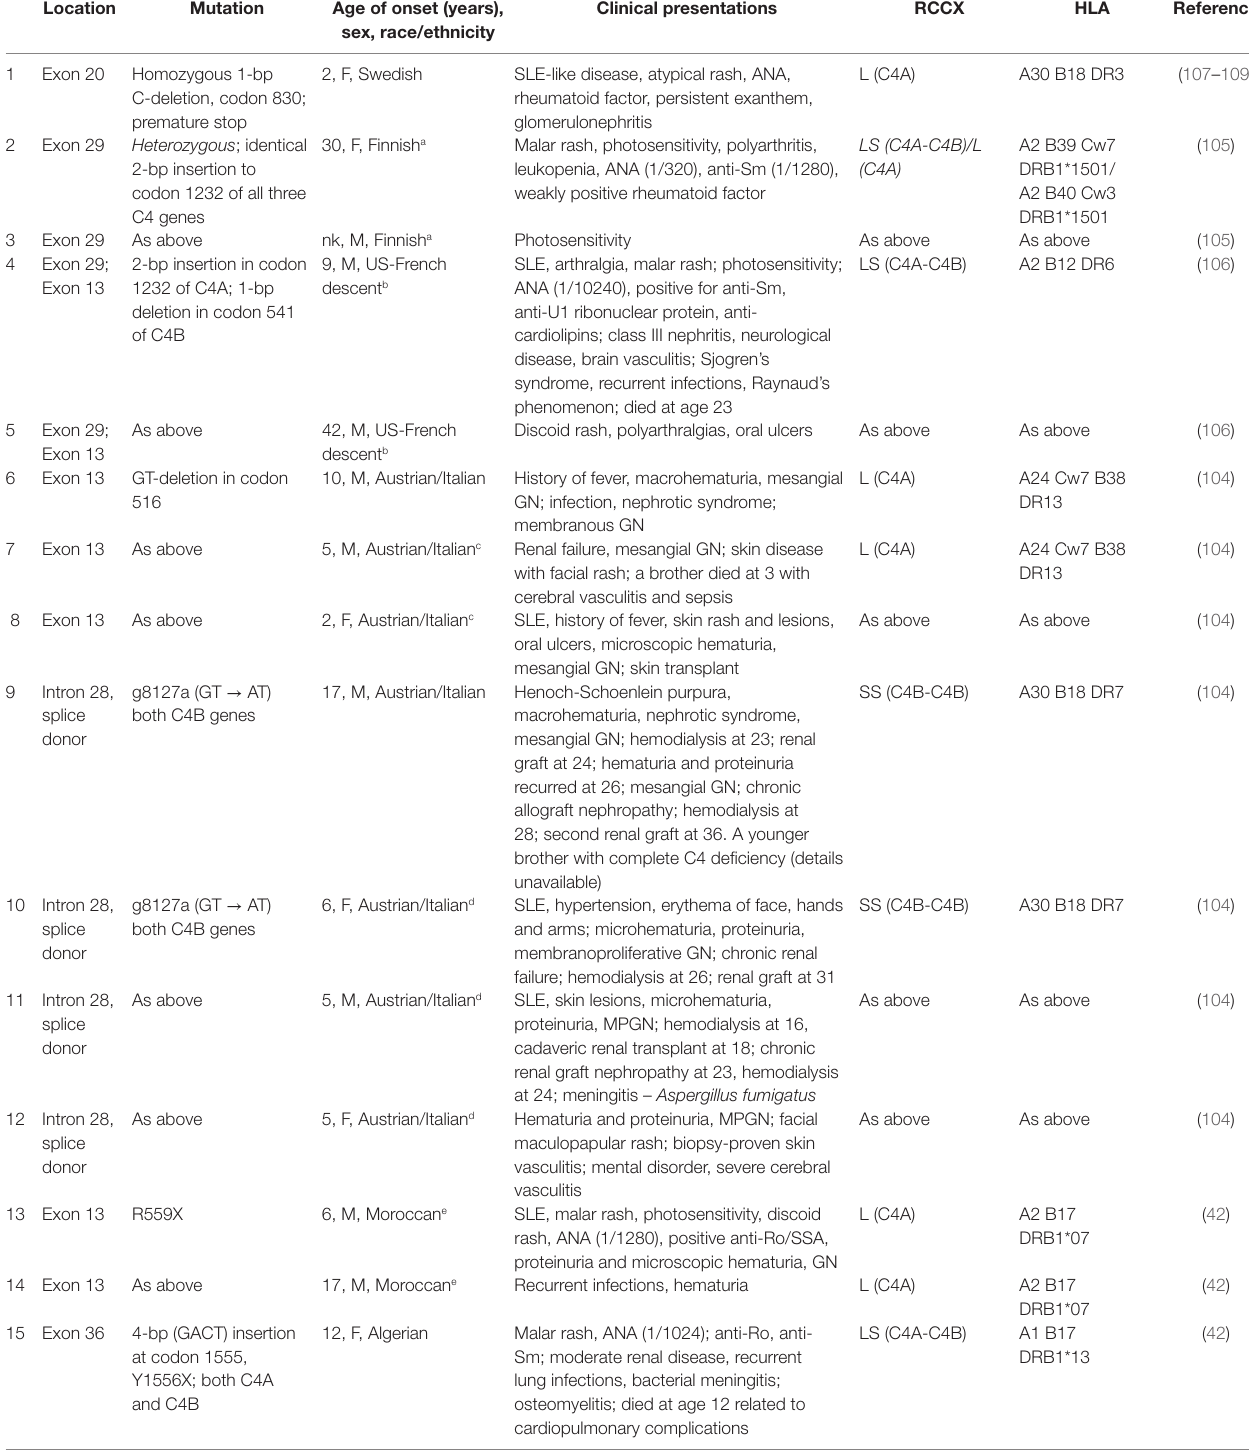
TABLe 3 | Molecular defects and clinical presentations of complete deficiency of complement C4A and C4B.